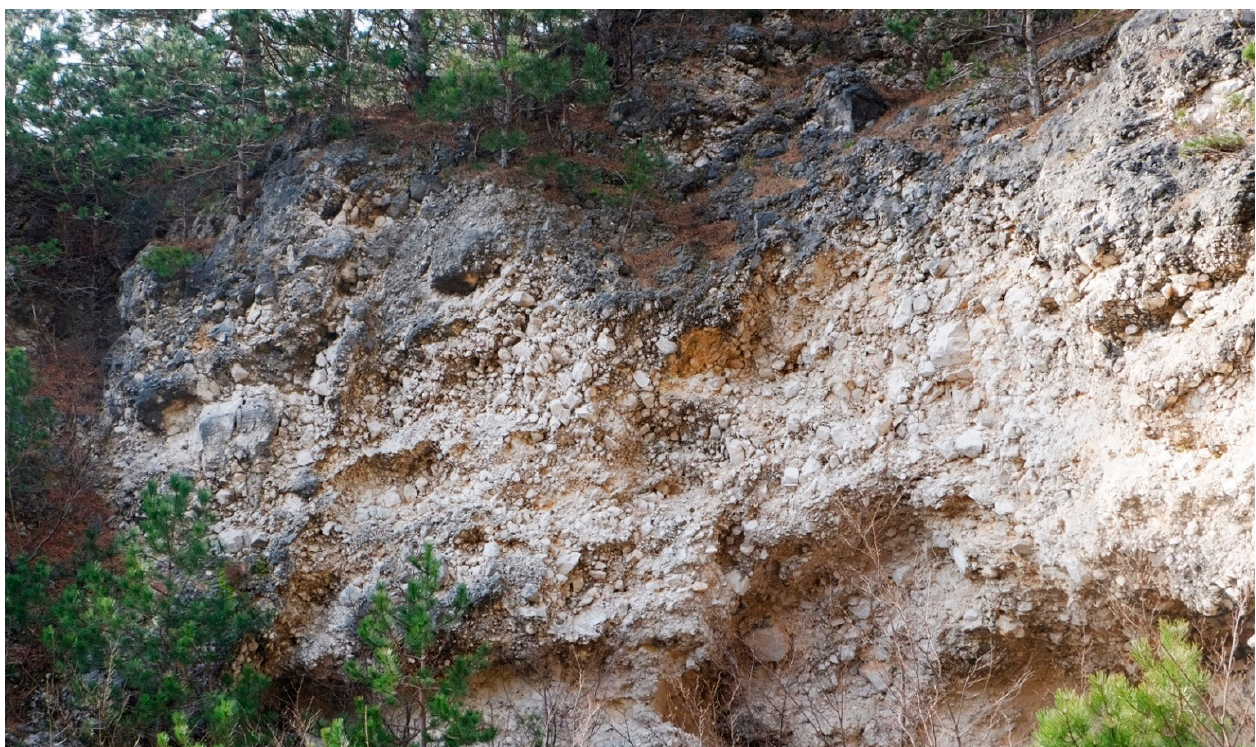
Figure 5. Up to a 10 m high wall of carbonate gravel, partly strongly lithified to breccia, in the lower part of the lateral scarp of the Podrta gora fossil rock avalanche in the abandoned Apnenec quarry, above the village of